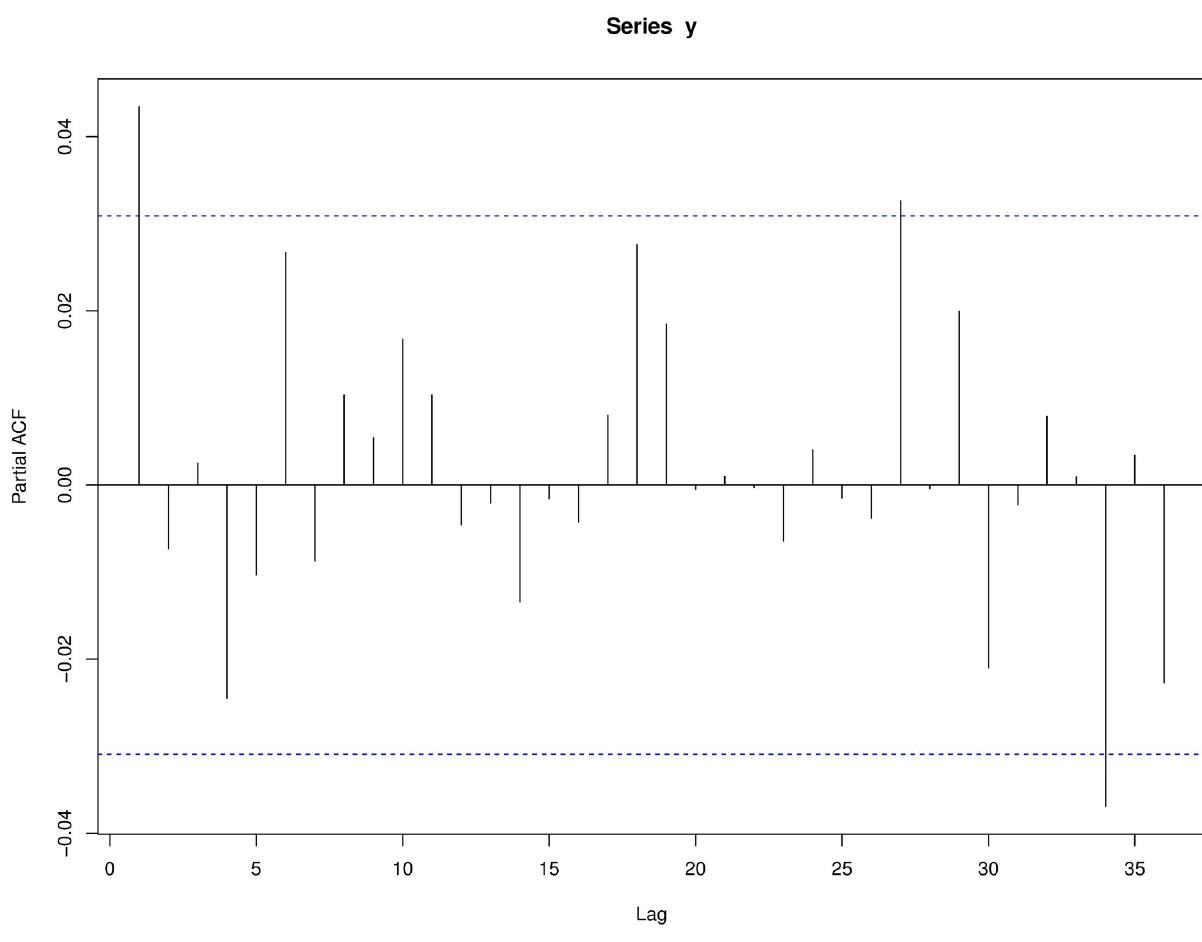
Fig 8. Partial autocorrelation function of events.